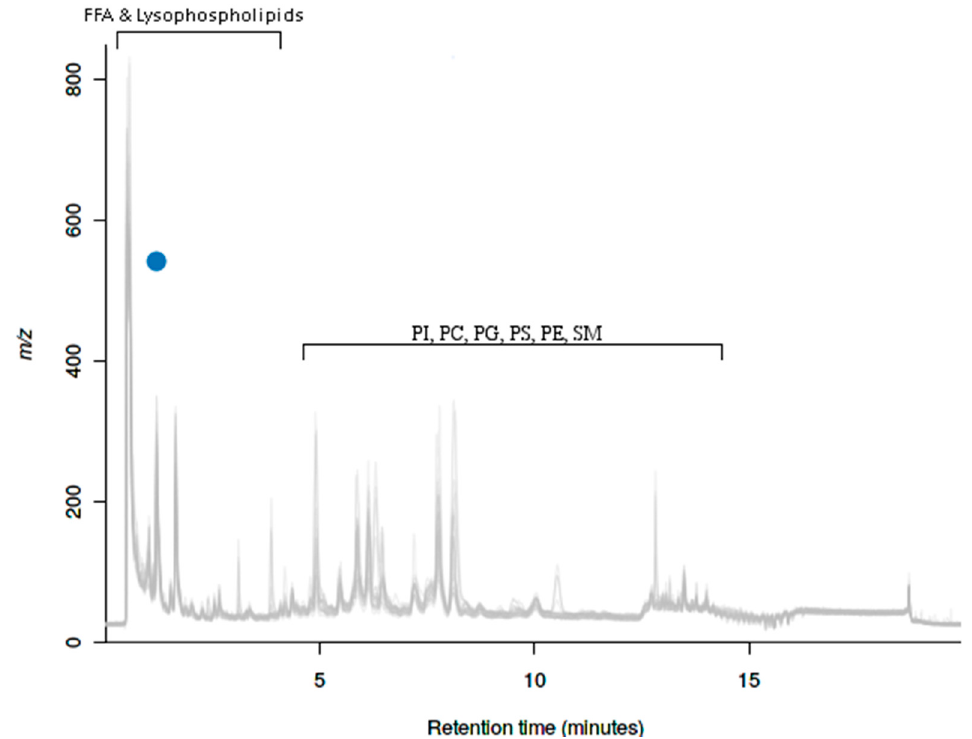
Figure 8. Cloudplot of the multigroup comparisons of the total ion chromatograms of winter fasted, winter fed and autumn fed with metabolic data visualization in the negative ionization mode. The two blue spheres represent the variably expressed features between the groups. The color of the sphere indicates the p-value of the feature (the lower the p-value the darker the color) and the larger diameter indicates the fold change e.g. the abundance and intensity of the feature (the larger the diameter the larger intensity of the feature). Hyphenations in the figure: FFA, free fatty acids; PI, phosphatidylinositols; PS, phosphatidylserines; are denoting the common retention times in the system for the different metabolites, which were added in the figure for visualization.